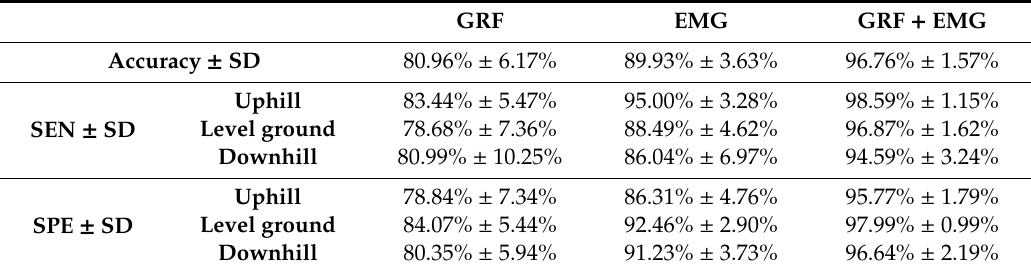
Table 5. The average and standard deviation (SD) of the accuracy, sensitivity and specificity of the model using di ff erent sets of